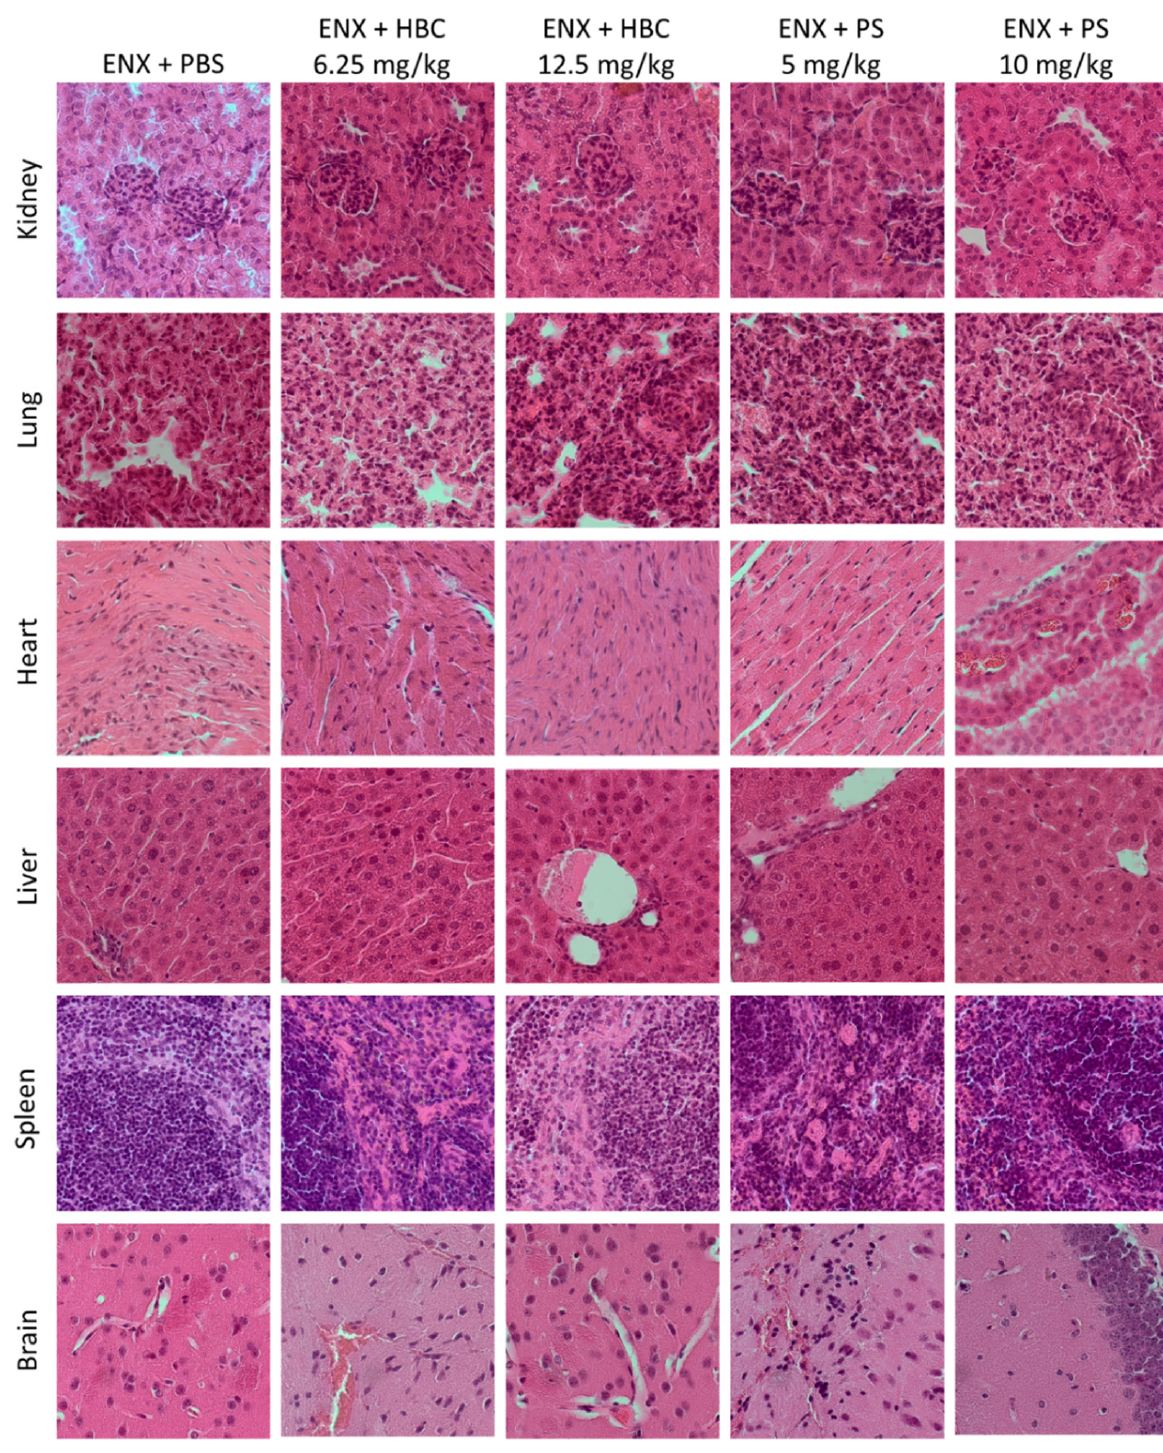
Figure 4. Representative micrographs of tissue sections of kidney, lung, heart, liver, spleen, and brain sections of mice treated subcutaneously with enoxaparin (ENX) (5 mg/kg) and an intravenous bolus of vehicle, HBC (6.25 and 12.5 mg/kg) or protamine sulfate (PS) (5 and 10 mg/kg). Organs were harvested 10 hours after antidote administration. Original magnification, 400×; hematoxylin and eosin staining. PBS, phosphate buffered saline.